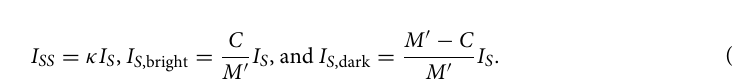
Figure 3. Three bar images obtained by using CGI with an external thermal noise source and those of CGI with noise-induced patterns. The small pictures show examples of the noise-induced patterns. We calculate contrast- to-noise ratio (CNR) and its standard deviation